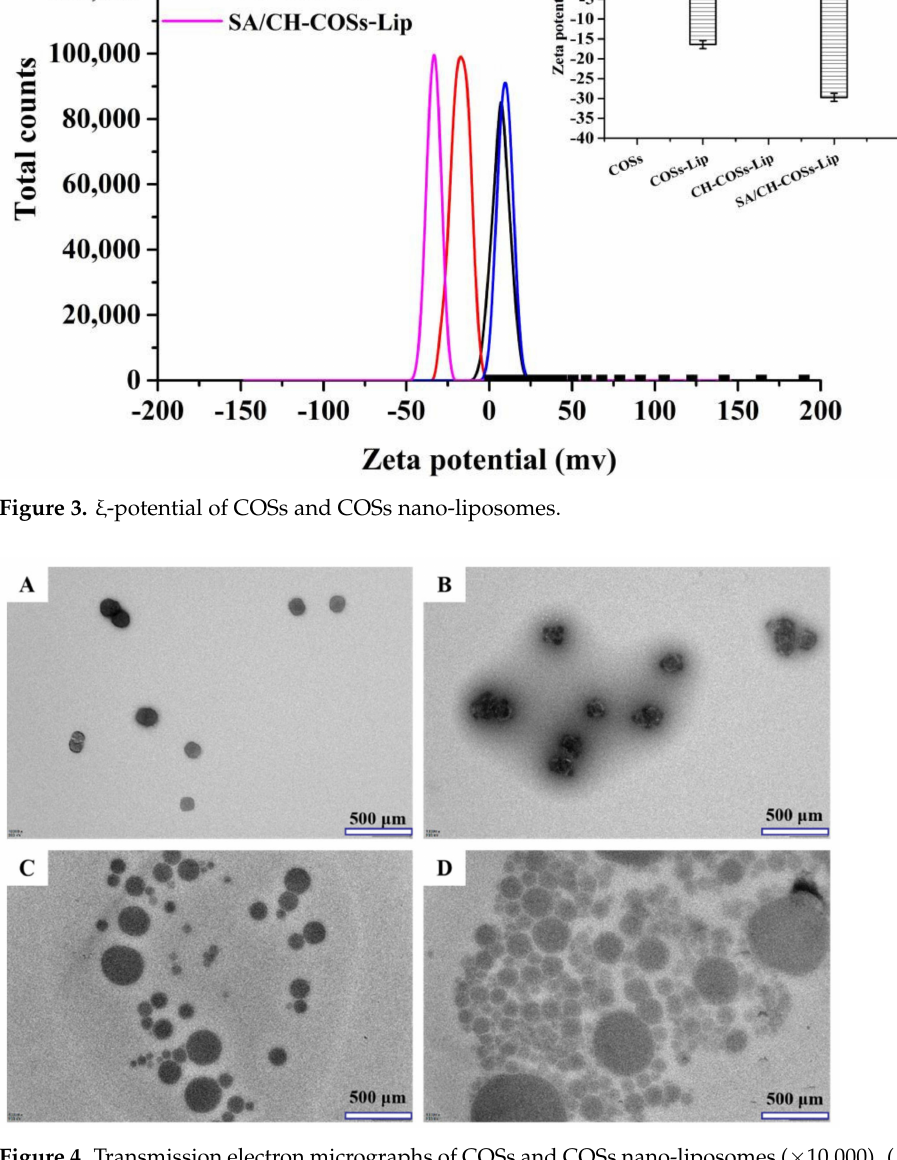
Figure 4. Transmission electron micrographs of COSs and COSs nano-liposomes ( × 10,000). ( A ) COSs. ( B ) COSs-Lip. ( C ) CH-COSs-Lip. ( D )